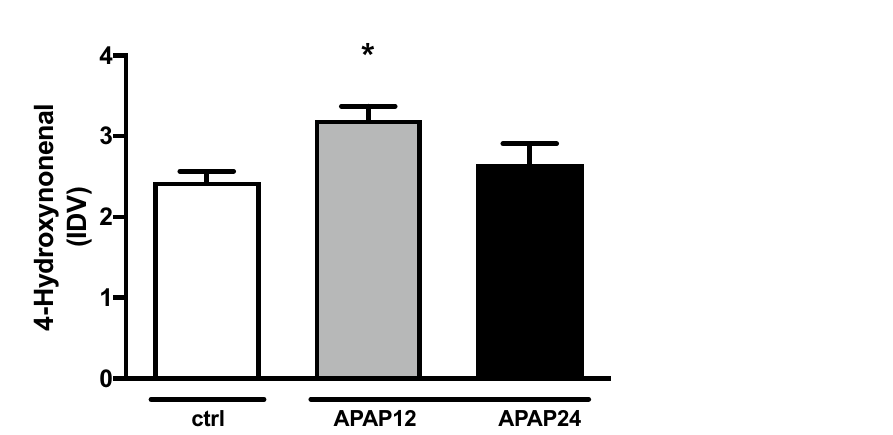
Figure 4. Inflammatory response in diaphragm tissue. IL-6, IL-10, TNFalpha and IL-1b mRNA expression relative to ctrl demonstrating a significant increase in IL-6 after APAP 12 N-acetyl-para-amino phenol 12 h treatment; APAP 24 N-acetyl-para-amino phenol 24 h treatment compared to control (ctrl). Values are mean and standard deviation *p < 0.02.